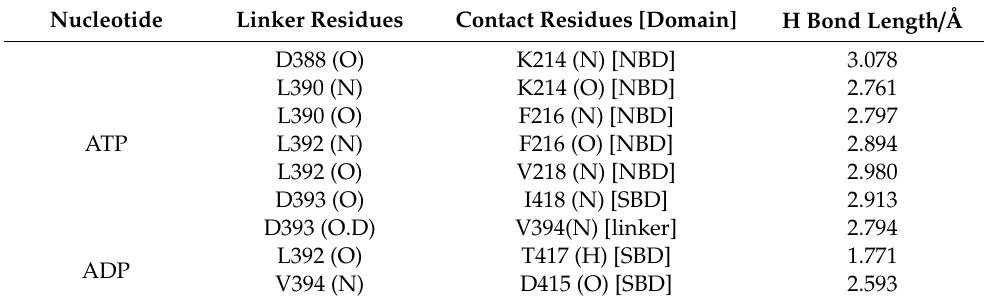
Table 2. Linker residues involved in Hydrogen bond formation upon ATP / ADP